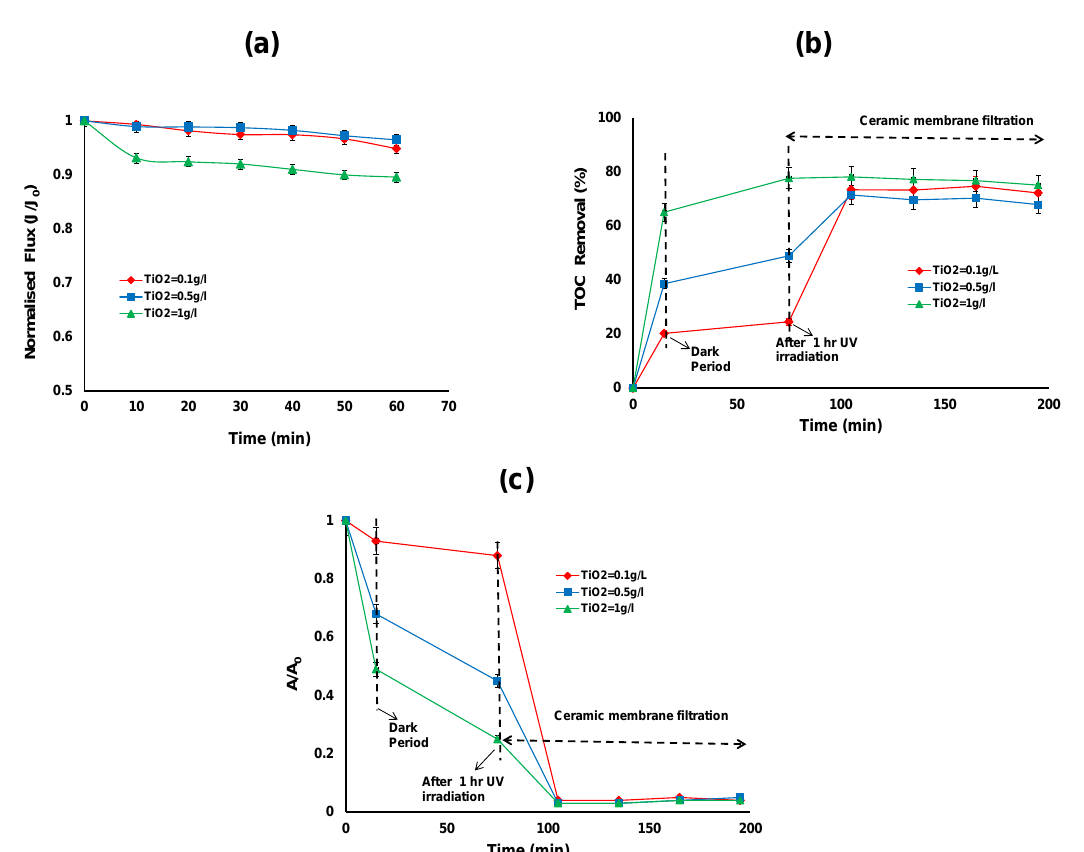
Figure 4. ( a ) Normalised flux ( b ) TOC removal efficiency; ( c ) reduction in UV absorbance of the photocatalytic—ceramic membrane integrated system for various TiO 2 concentrations (HA concentration: 20 mg/L, TMP: 100 kPa, CFV: 0.4 m/s; pH: 7.5; UV intensity: 3.4 mW/cm 2 ).